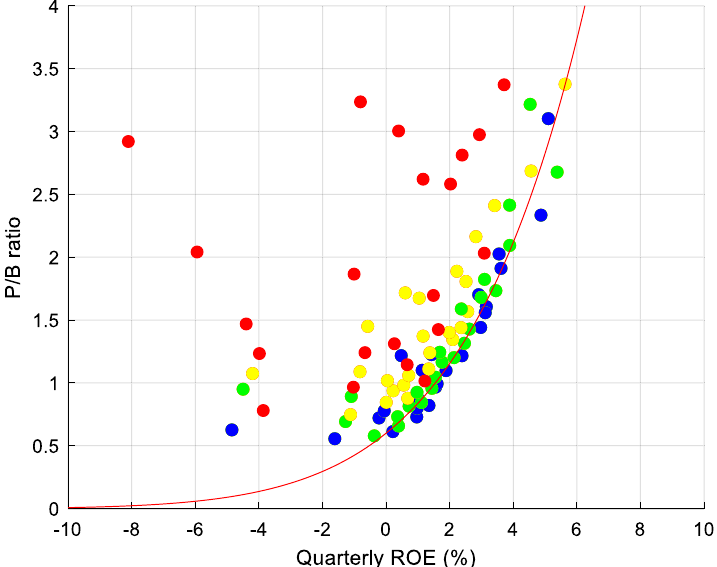
Fig. 33 The relationships among the ROE(t quantile, yellow: 25–50%, green: 50–75%, blue: